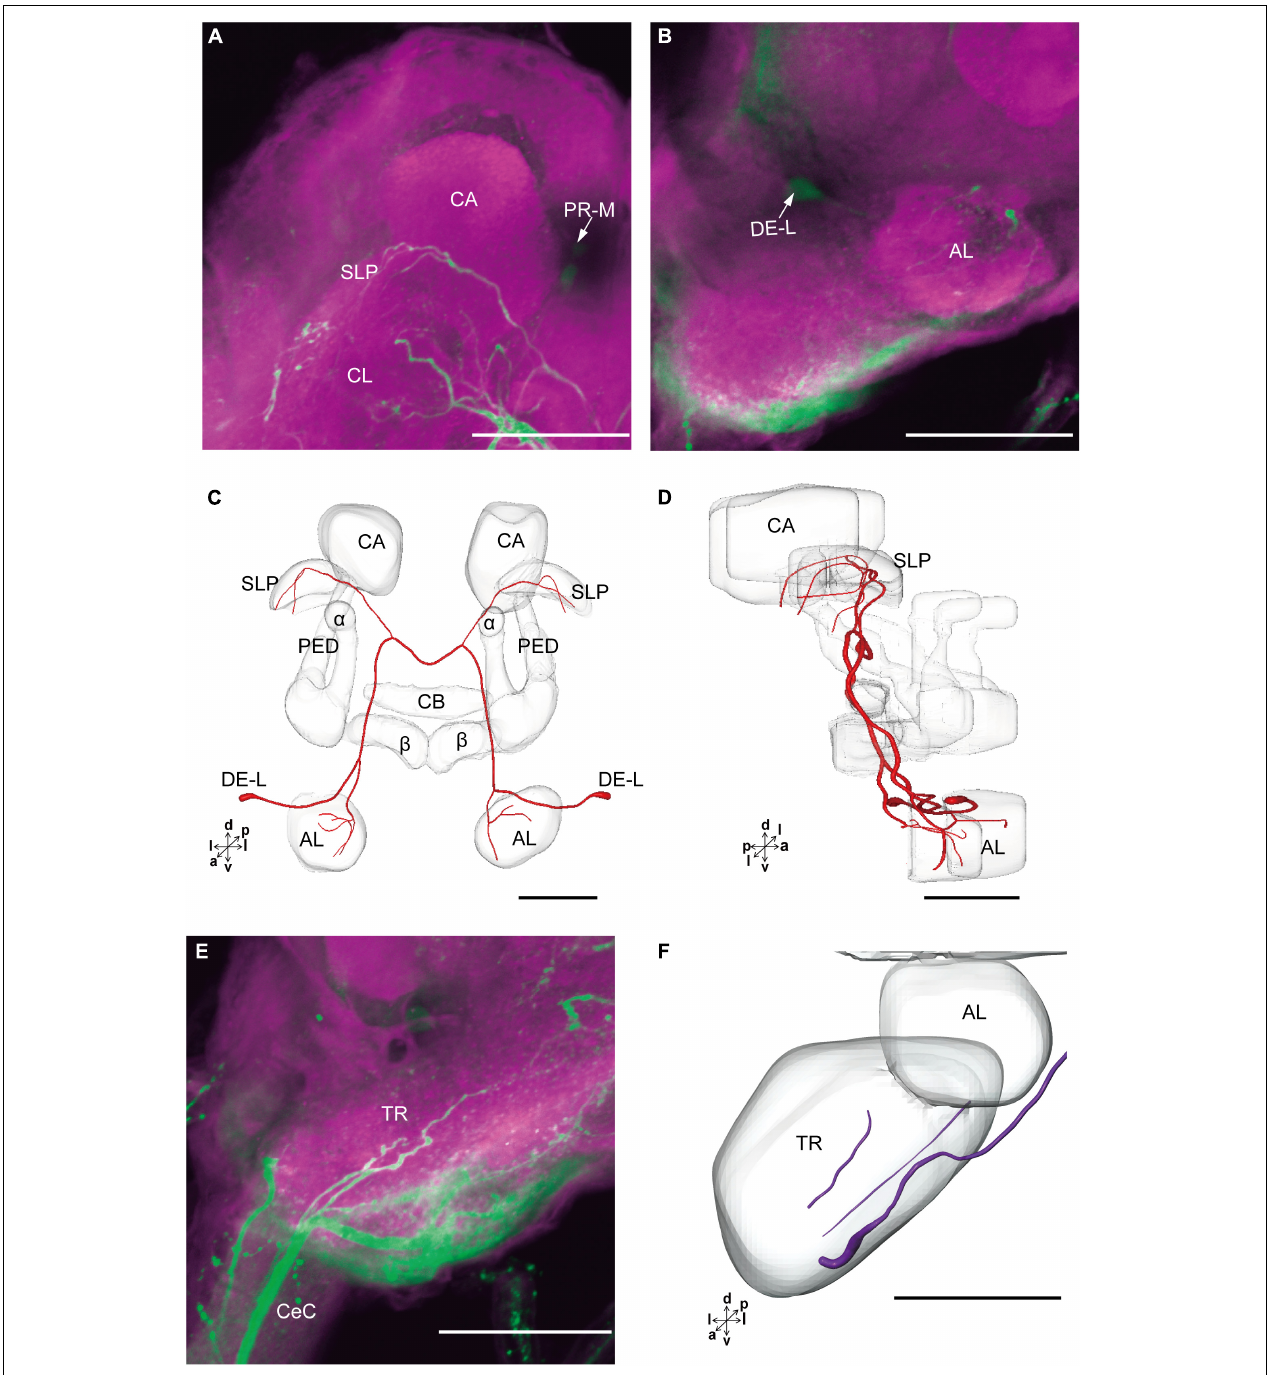
FIGURE 5 | The projection area of DE-L and TR neurons. (A,B) The confocal stack images of DE-L neurons. (C,D) The anterior and lateral views of the three-dimensional reconstructions of the DE-L neurons. (E) The confocal stack images of TR neuron. (F) The three-dimensional reconstructions of the TR neurons in anterior view. α , alpha lobe; AL, antennal lobe; β , belta lobe; CA, calyx; CB, central body; CeC, circumoesphageal connective; PED, pedunculus; SLP, superior lateral protocerebrum; PR-M and DE-L are cell clusters. Directions: a, anterior; d, dorsal; l, lateral; p, posterior; v, ventral. Scale bars, 100 µ m.